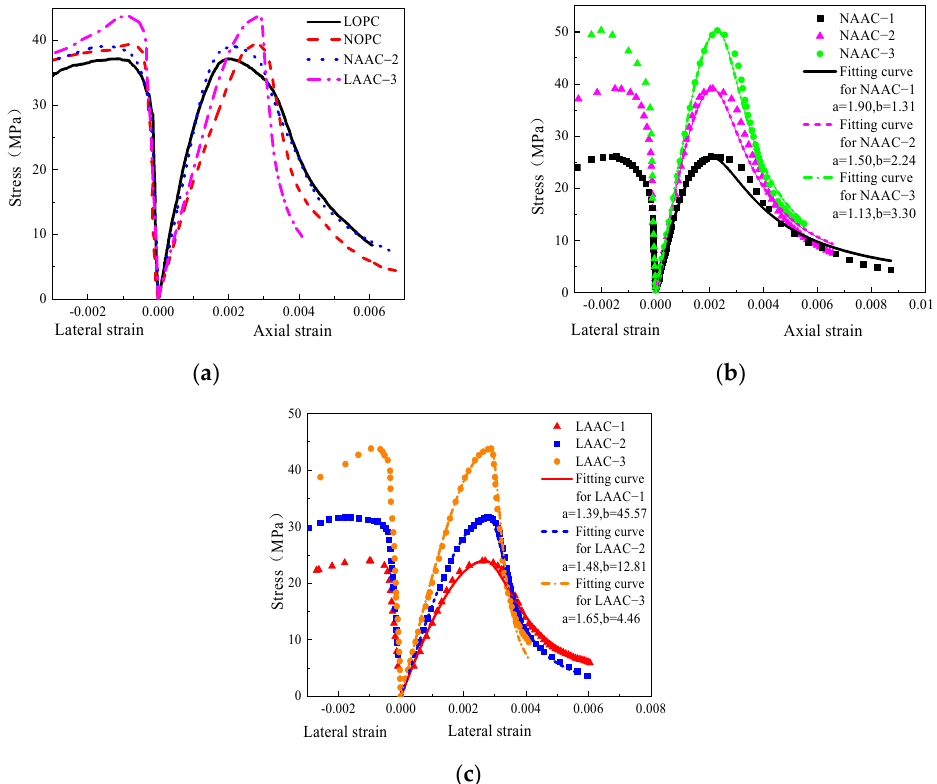
Figure 4. Compressive stress–strain curves of the tested prisms: ( a ) stress–strain curves of different mixtures; ( b ) stress–strain curves of NAAC; ( c ) stress–strain curves of LAAC.